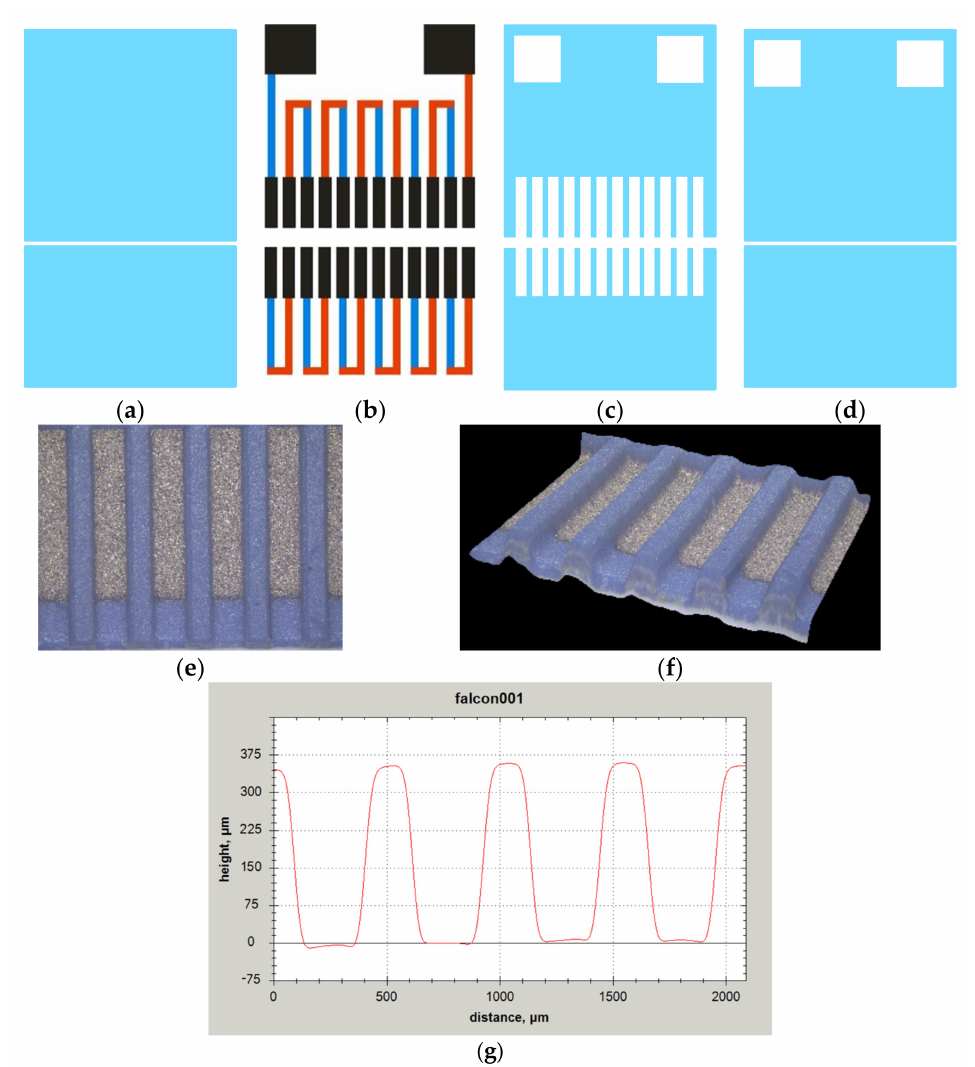
Figure 11. Schematic and profile cut on sensor structure: ( a ) the base tape; ( b ) the thermocouples legs; ( c ) laser cut tapes (three tapes); ( d ) the cover tape; ( e,f ) 3-D photo of the structure without the cover tape; ( g ) profile of the structure without the cover